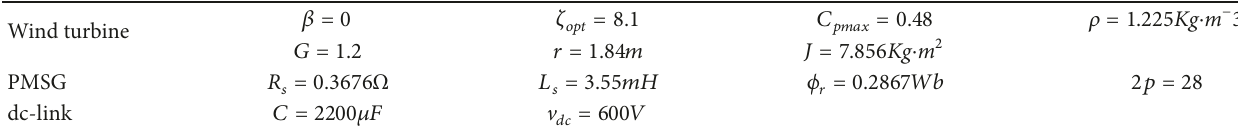
Table 1: Nominal values of PMSG WECS parameters.